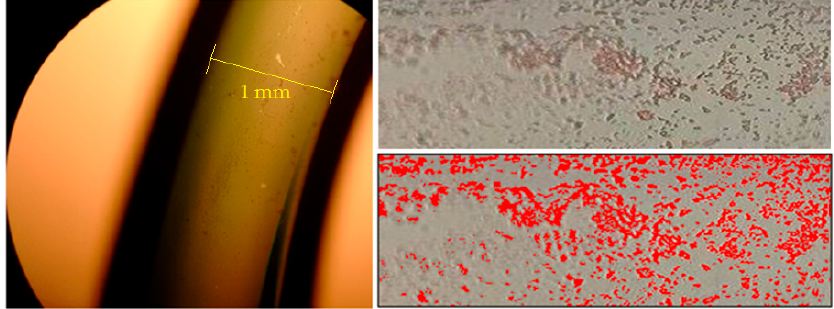
Figure 13. Optical microscope image (40×) of E. coli coverage over the 70 nm probe after immersion in a bacteria suspension at 1.5 × 10 8 CFU/mL concentration. In left, the probe microscope image. In upper right, a 40× magnification image of the bacteria adhered to the fiber surface colored by safranin solution. In bottom right, the coverage area in red estimated by the ImageJ. The coverage area estimated by ImageJ software was 16%.